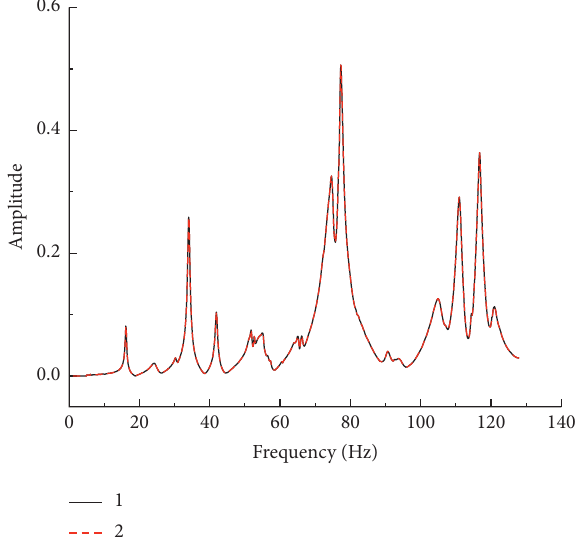
Figure 6: Difference of DA between two times taps for the same aim point.